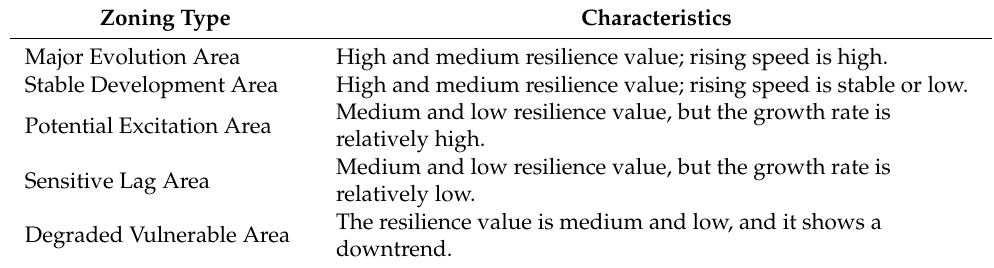
Table 2. Zoning Rules of Cultivated Land Use System Resilience